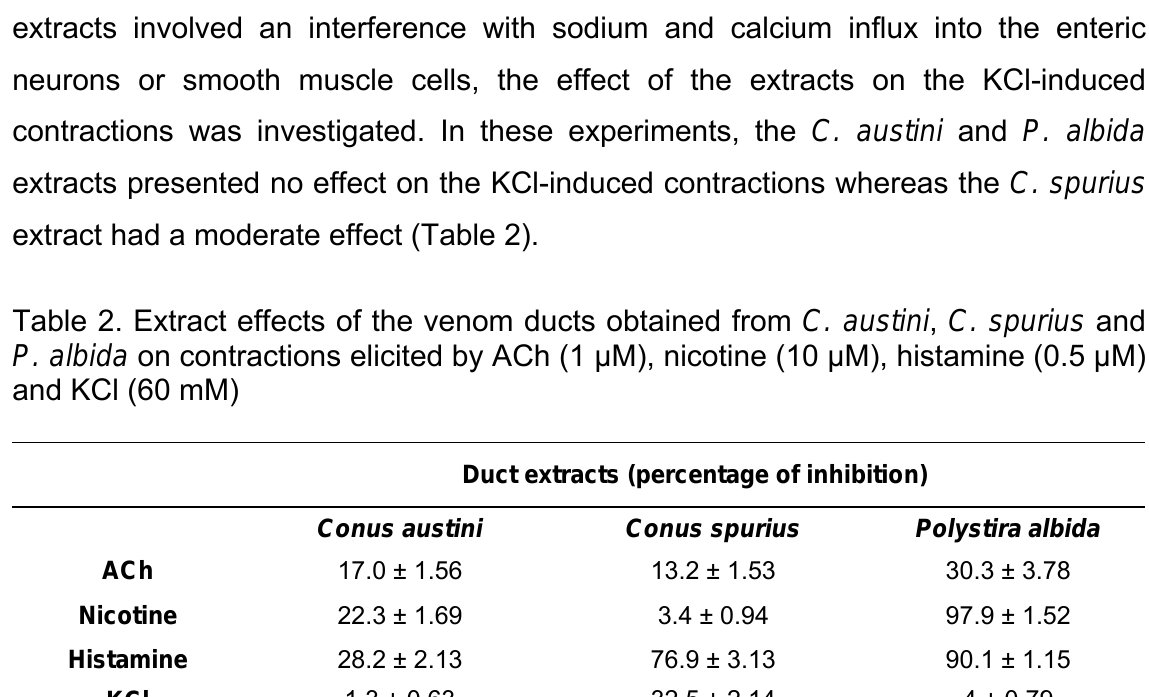
Values are means ± SEM; n =